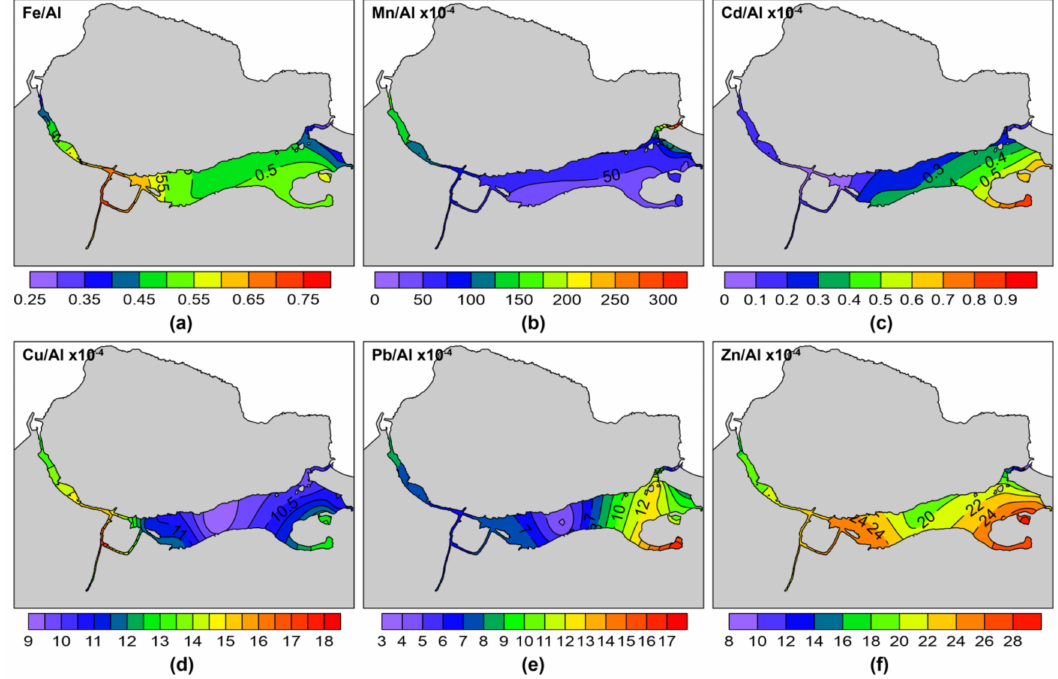
Figure 6. Spatial distribution of ( a ) Fe / Al, ( b ) Mn / Al, ( c ) Cd / Al, ( d ) Cu / Al, ( e ) Pb / Al, and ( f ) Zn / Al values in the surface sediments of the Antinioti